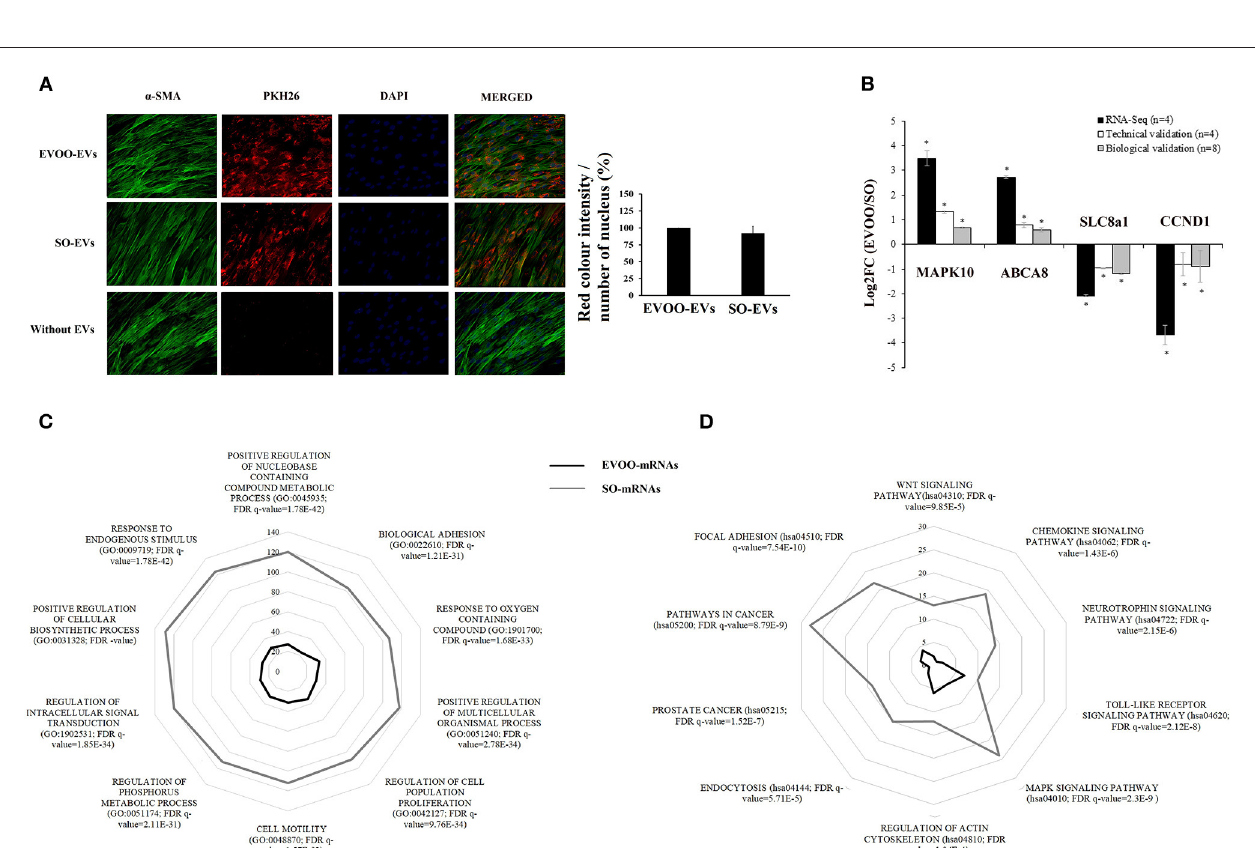
FIGURE 3 | (A) Microscopy analysis of EVs internalization. SMCs were incubated for 24h with EVOO-EVs and SO-EVs dyed with PKH26. Negative control without EVs is also shown. Analysis of the intensity of red color (EVs)/number of nucleus is also shown ( n = 2). (B) Technical and biological validation of 2 up and 2 downregulated DE-mRNA obtained from SMCs incubated with EVOO-EVs and SO-EVs. Data from mRNA-Seq (in black) ( n = 4 per group), from technical validation [in the same samples ( n = 4 per group)] (in white), and from biological validation (in the same 4 samples per group plus another 4 samples per group) (in gray). Data are represented as the mean ± SEM. Log2FC: Fold Change in the expression of each gene. * P < 0.05: significant Log2FC in the up/downregulated mRNAs. (C) Number of DE-mRNAs of EVOO-mRNAs (black) and SO-mRNAs (gray) involved in the 10 most differentially expressed GO:BP. (D) Number of DE-mRNAs of EVOO-mRNAs (black) and SO-mRNAs (gray) involved in the 10 most significant KEGG pathways.